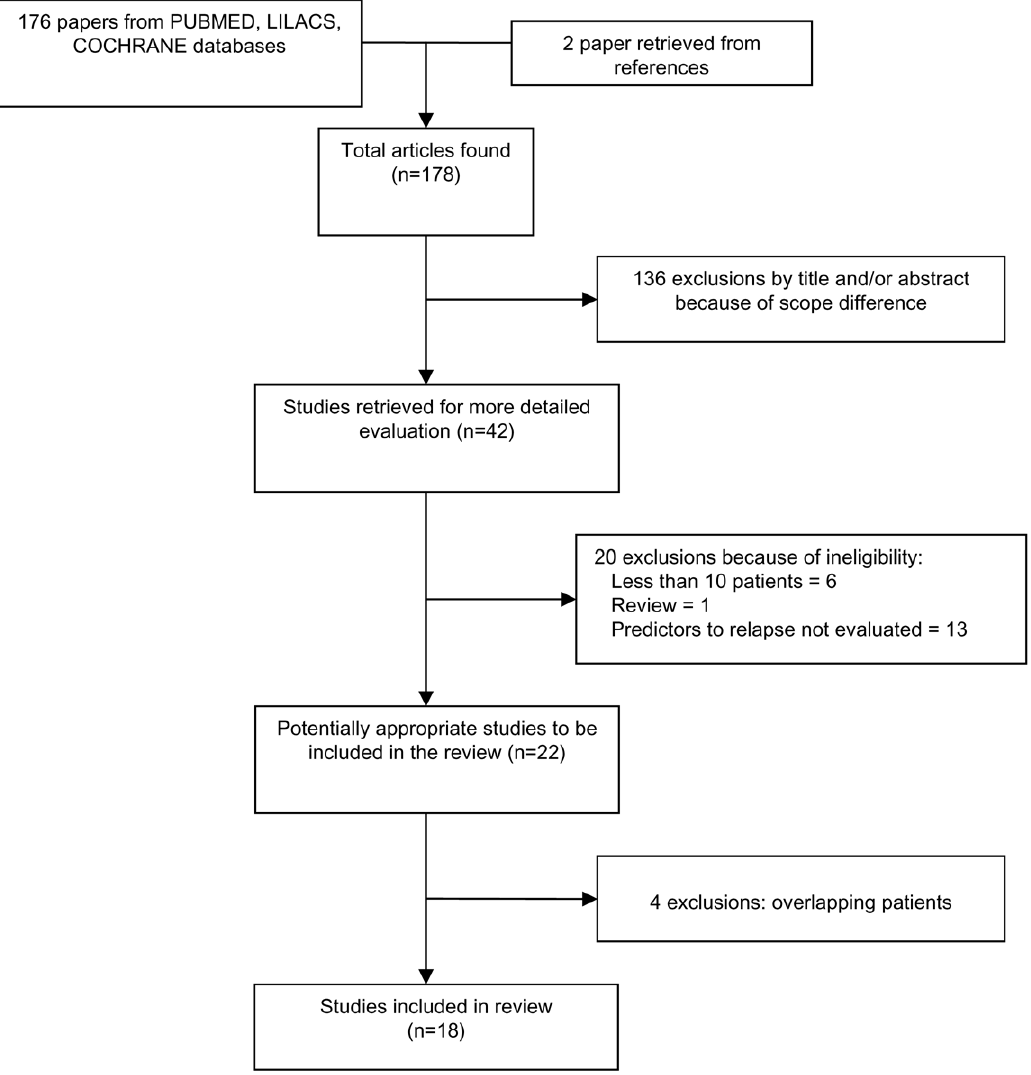
Figure 2. Study selection process.